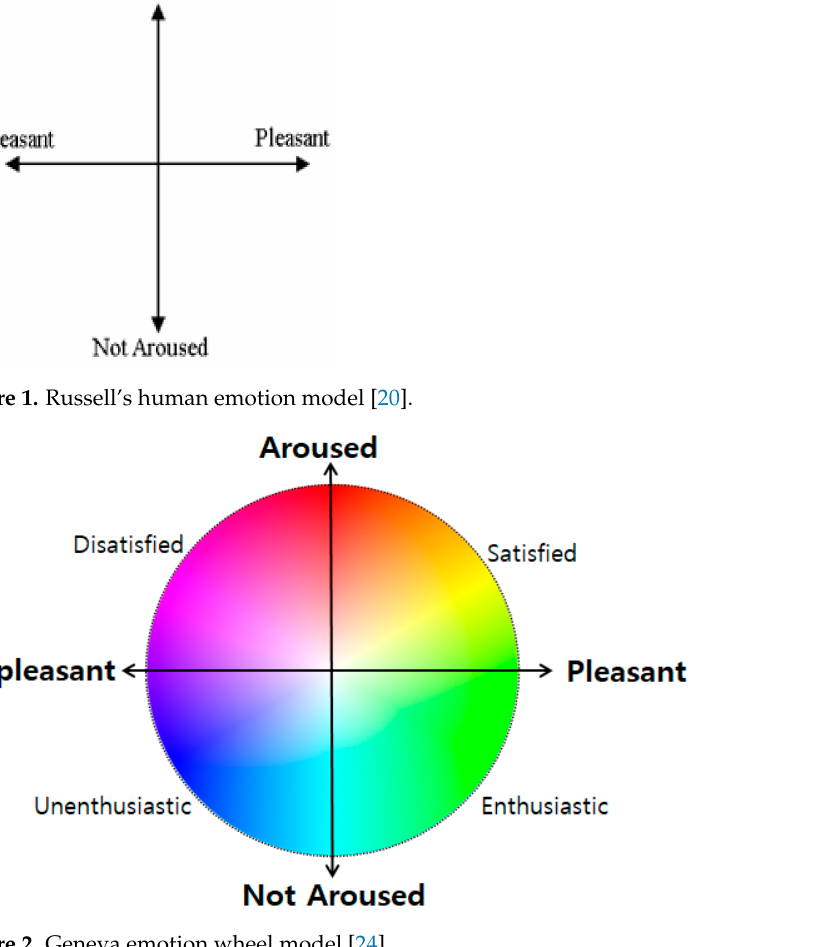
Figure 2. Geneva emotion wheel model